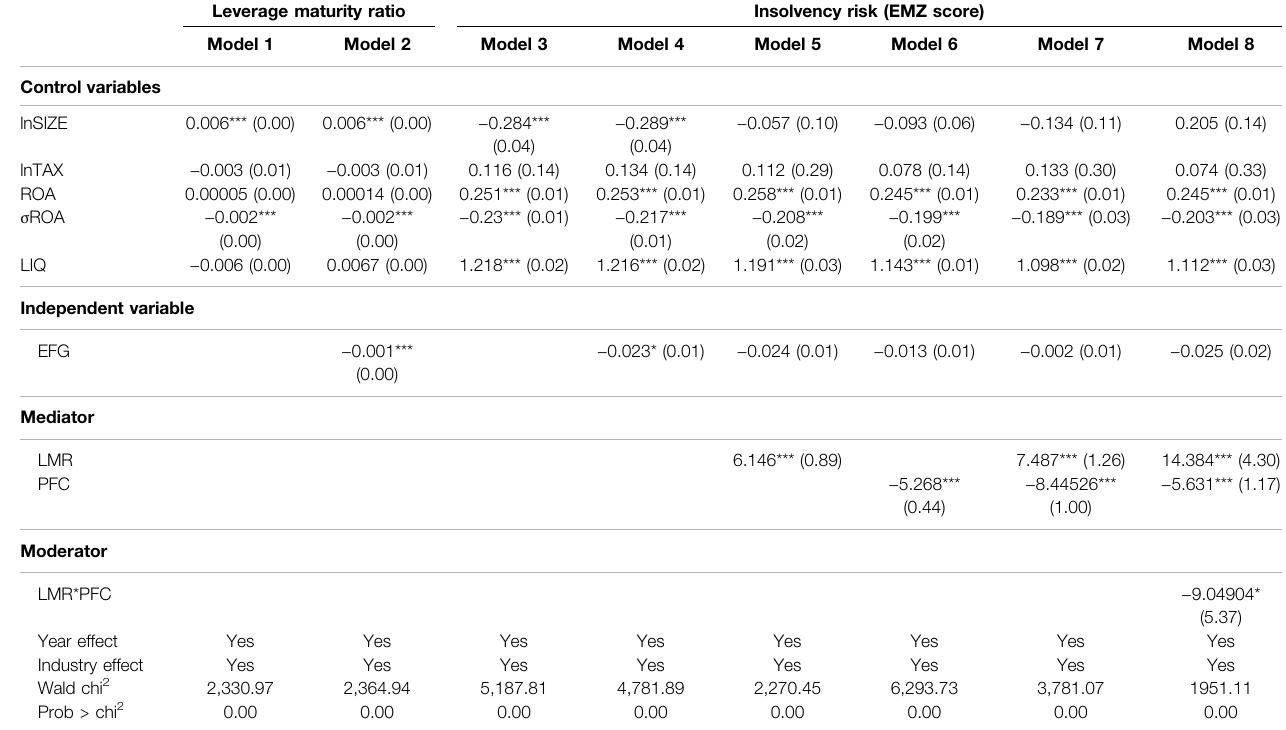
TABLE 9 | Hierarchical FGLS regression results with EFG as